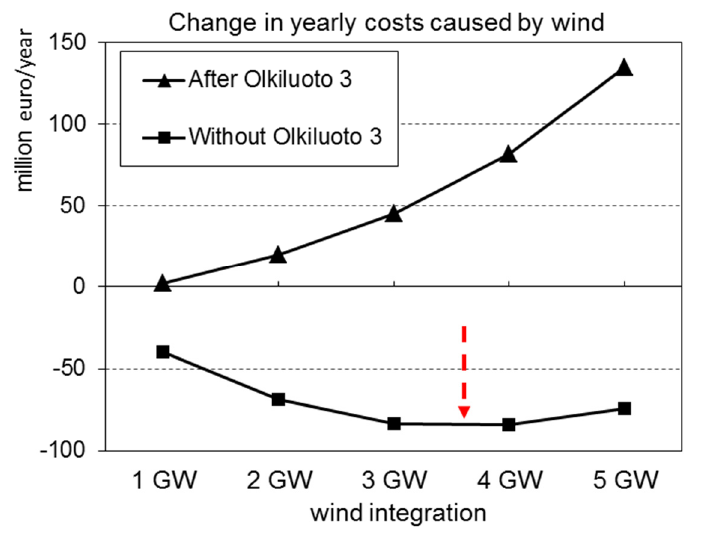
Figure 7. Changes in total annual costs of the Finnish energy system in wind integrations up to 5000 MW with and without the new nuclear plant (OL3), (interest rate